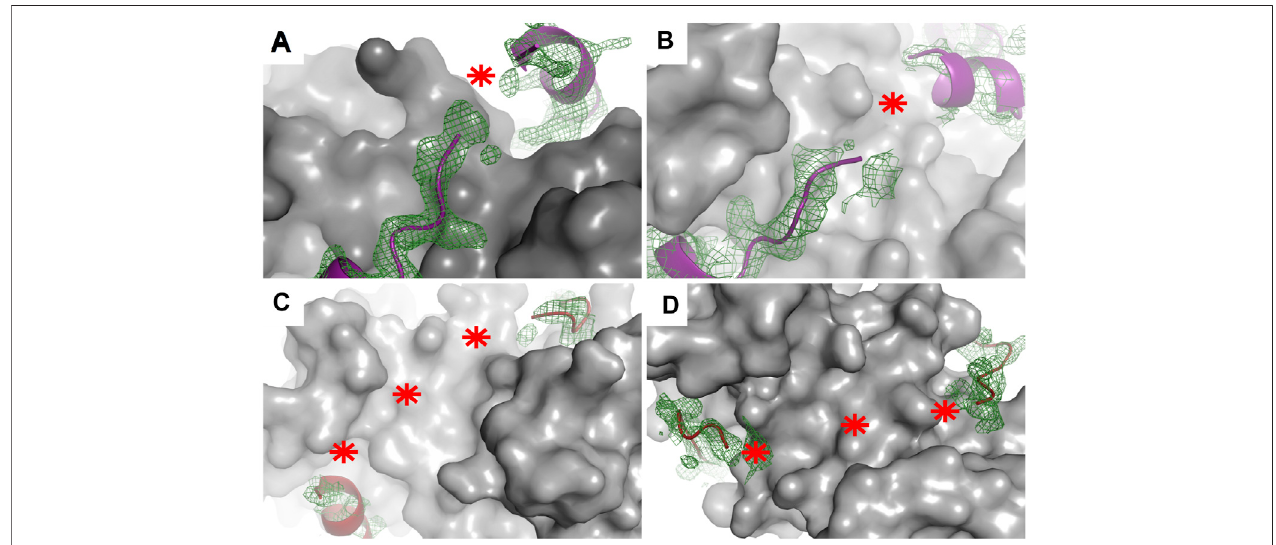
FIGURE 4 | Electron density maps of fl exible regions in S100 complexes indicating fuzziness. Structures of (A) p53 TAD 17 – 56 – S100P (PDB: 7NMI), (B) p53 TAD 17 – 56 – S100A4 (PDB: 6T58) (Ecsédi et al., 2020), (C) RSK1 683 – 735 – S100B in one crystal form (PDB: 5CSN), and (D) RSK1 683 – 735 – S100B (PDB: 5CSJ) in another crystal form (Gógl et al., 2016). S100 proteins are displayed as gray surface representations and their partners as deep purple (p53 TAD 17 – 56 ) and red (RSK1 683 – 735 ) ribbons. The green meshes around the partner peptides are simulated annealing Fo – Fc omit maps (contoured at 2 σ ). Red asterisks show the tracks of fl exible regions not appearing in the X-ray structures of these